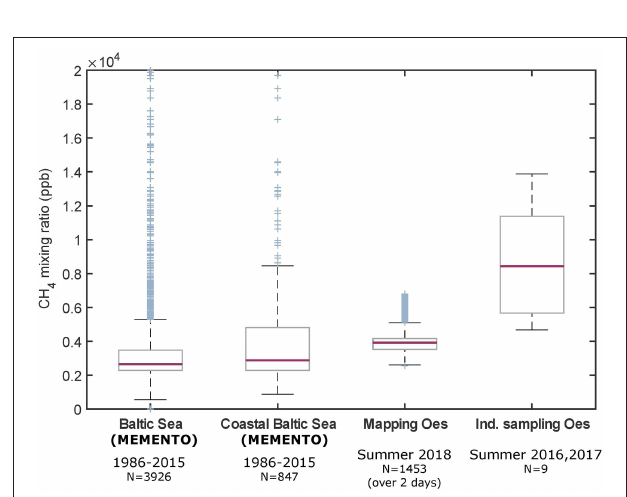
FIGURE 6 | Boxplots of CH 4 mole fraction in the seawater. From left to right, the first two boxes represent data from MEMENTO database, the first one considers all data available for the Baltic Sea and the second one only data corresponding to regions with depth < 25 m, here defined as coastal Baltic Sea. The last two boxes represent data from the vicinities of Östergarnsholm site, where “Mapping Oes” shows results from the mapping campaign and “Ind. sampling Oes” the results of the individual sampling. “N” is the number of data points. The representation of the boxplots is the same as in Figure 5